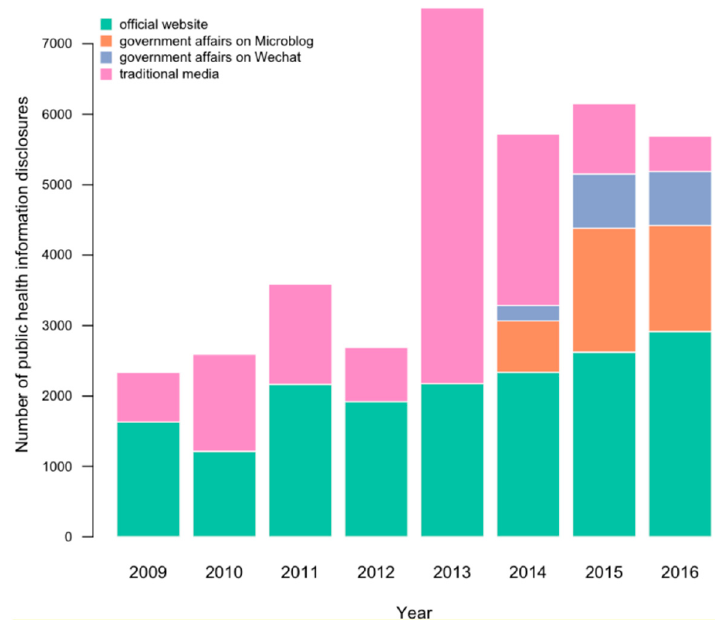
Figure 1. Disclosure of public health information in Hangzhou City, China.